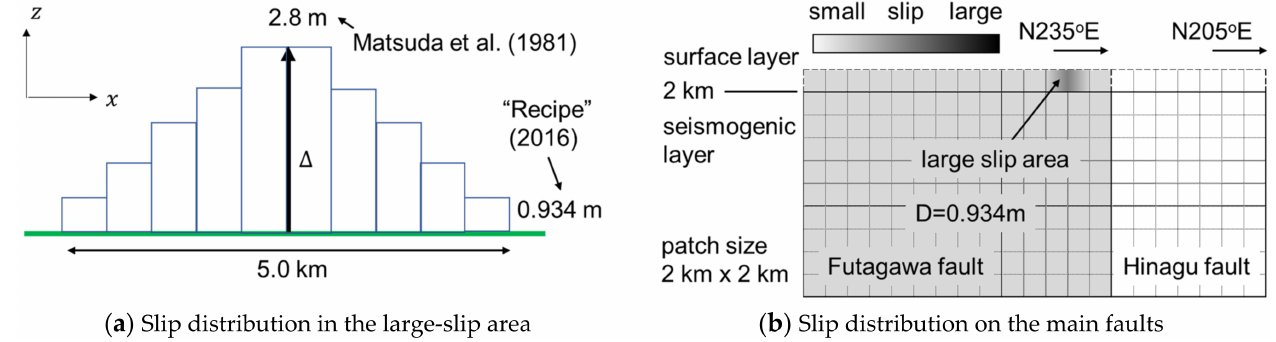
Figure 15. Setting the slip distribution with a large surface slip